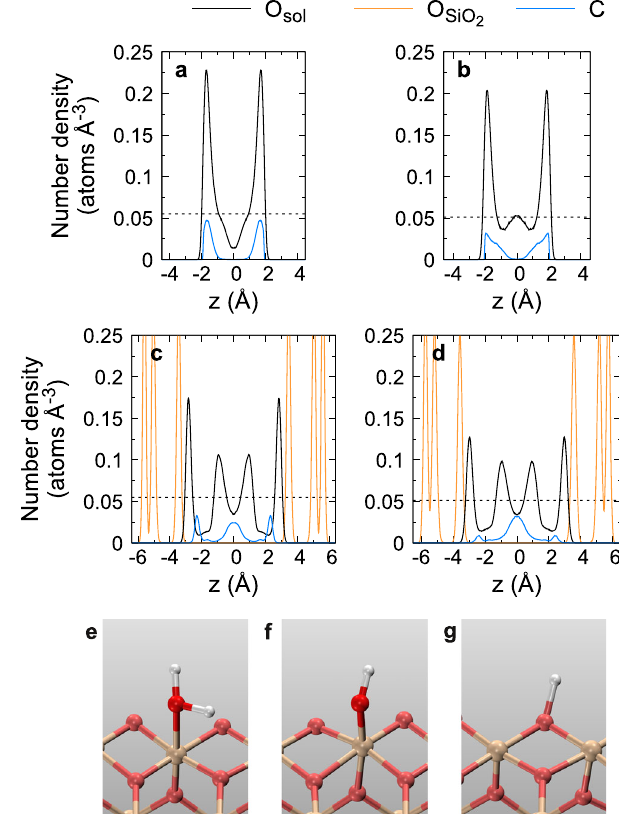
Fig.3|Numberdensitypro fi lesofoxygenatomsandcarbonatomsalongthe z axis, normal to the con fi ning surfaces. a , b The solutions under graphene con- fi nement at 1000 and 1400K, respectively. c , d The solutions under stishovite con fi nement at 1000 and 1400K, respectively. O sol refers to the oxygen atoms in referstotheoxygenatomsinstishovite(orangelines), solutions(blacklines),O SiO 2 and C refers to carbon atoms (blue lines). The initial mole fraction of CO 2 (aq) is 0.185. The pressure is ~10GPa. The center of con fi ned fl uids is set at z =0, and the density distributions have been symmetrized. The horizontal black dashed lines represent the oxygen density in the bulk solutions at the corresponding P-T conditions 44 . e – g The H 2 O molecule, the OH − , and H + ions bonded to the stishovite (100) surface, respectively.